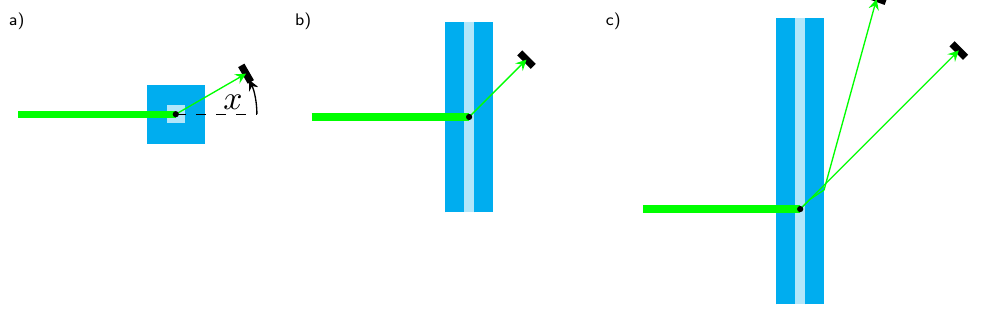
Figure 3. ( a ) Sensor rotated radially and ( b ) vertically and also with ( c ) consideration of the refraction at the interfaces. All given angles are with respect to the direction of